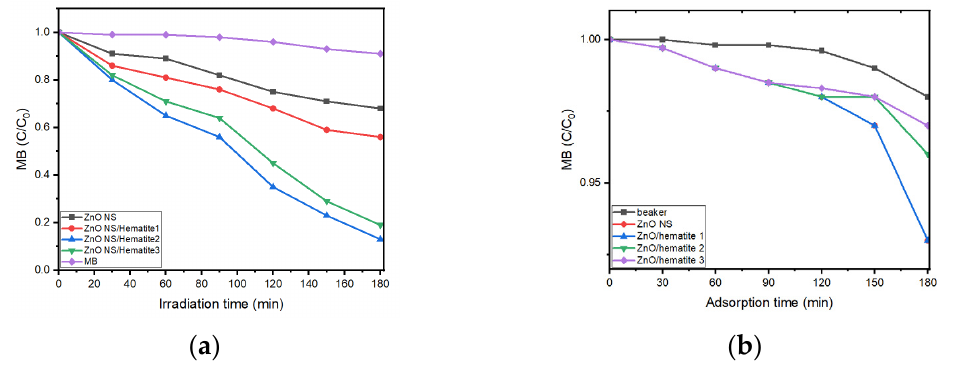
Figure 4. Decolorization of MB under in 180 min: ( a ) under irradiation, ( b ) in dark.